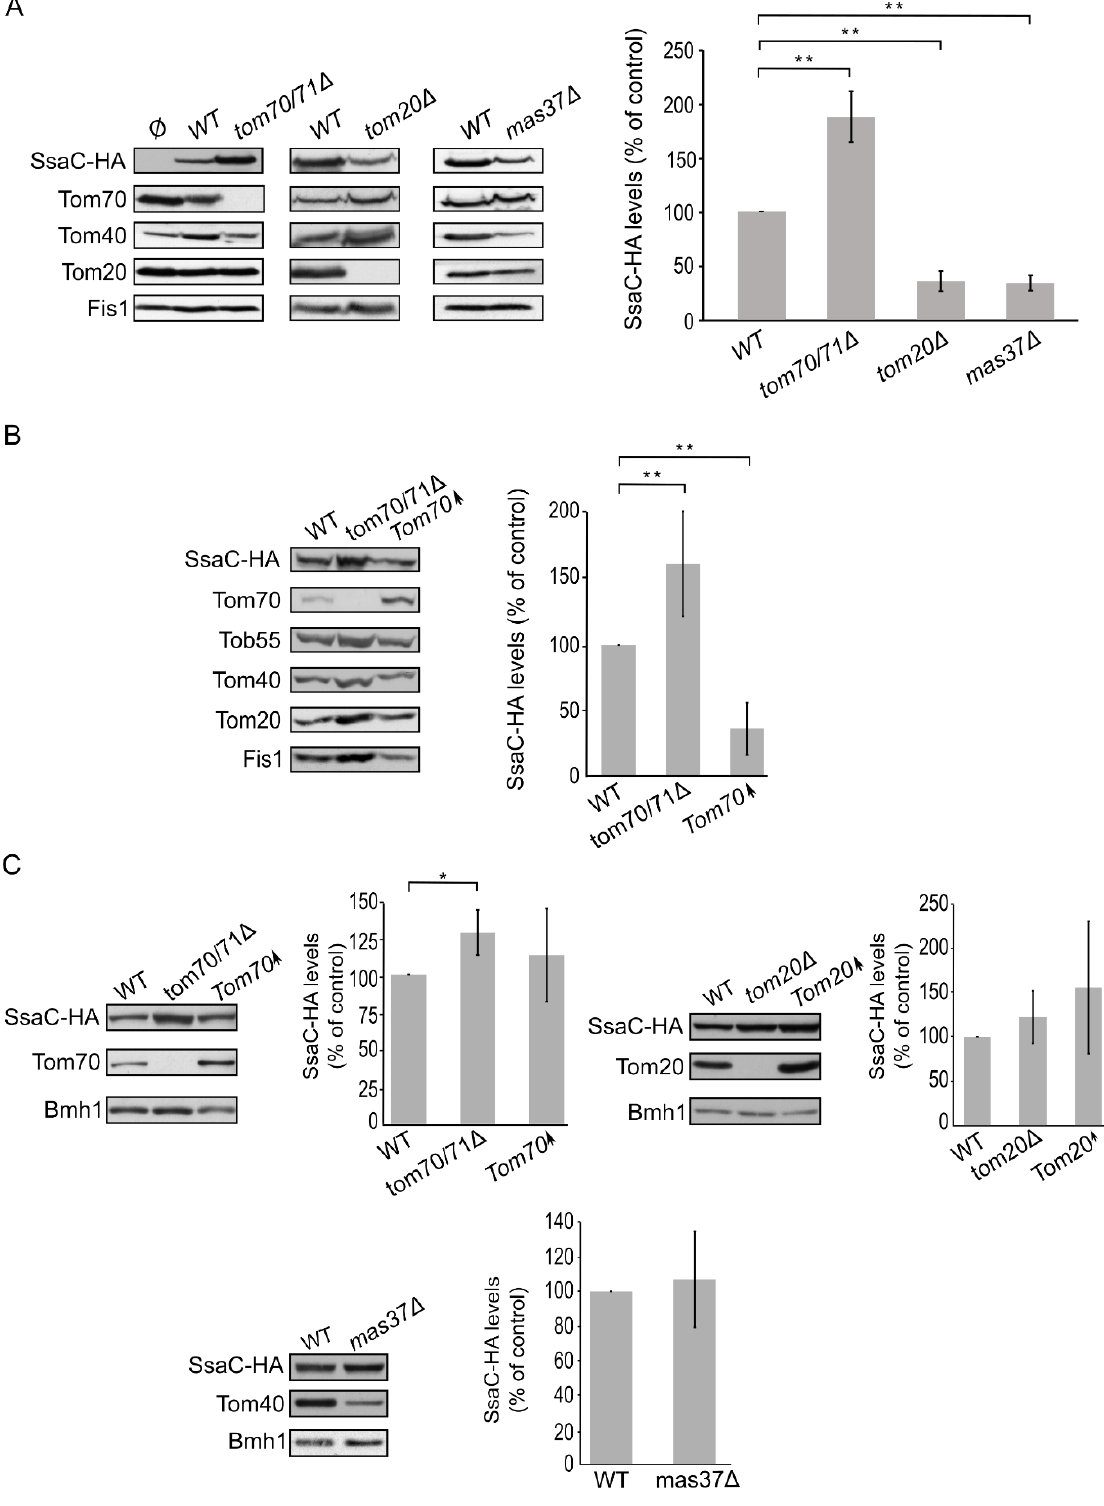
FIGURE 7: Lack of Tom70 improves the biogenesis of SsaC in mitochondria . (A) Isolated mitochondria were obtained from the indicated strains transformed with either an empty vector (Ø) or a plasmid encoding SsaC-HA. Further treatment and analysis were dones as de- scribed in the legend of Fig. 4A. (B) Crude mitochondria were obtained from widll type (WT), tom70/71 Δ or a strain overexpressing TOM70 (Tom70↑) harbouring a plasmid encoding SsaC -HA. Further treatment and analysis were done as described in the legend of Fig. 4B. (C) Whole cell lysate was obtained from the indicated cells and was analysed by SDS-PAGE followed by immunodecoration with antibodies against the indicated proteins. The steady state levels of SsaC-HA in at least three experiments for each strain were quantified and further analysis was as described in the legend of Fig. 6D. (*, P < 0.05; two tail ed Student's